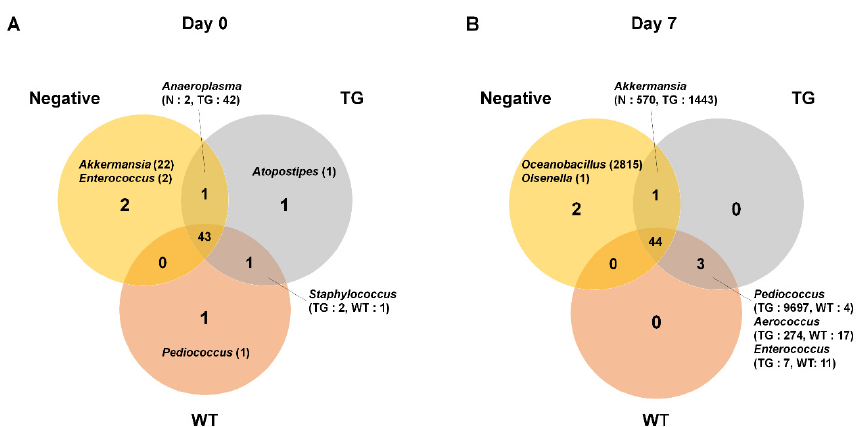
Figure 5. Comparison of identified bacteria in three different conditions based on genus. The identified bacterial genera in each condition were compared at two individual time points of day 0 ( A ) and day 7 ( B ) and visualized by Venn-diagram. Orange, gray, and pale red circles indicate N, TG, and WT conditions, respectively. Bacteria genera that were condition specific or commonly identified in two conditions were indicated with number of read counts. For each condition, bacterial genera from three replicates were combined regardless of number of read counts.